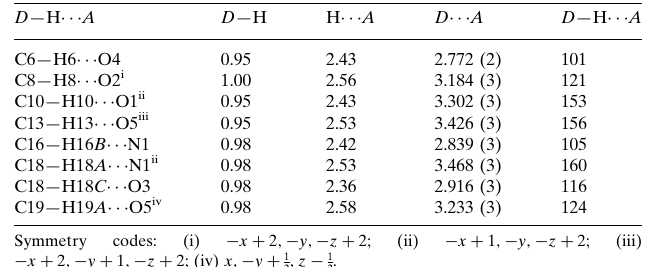
Hydrogen-bond geometry (A˚ , (cid:1)